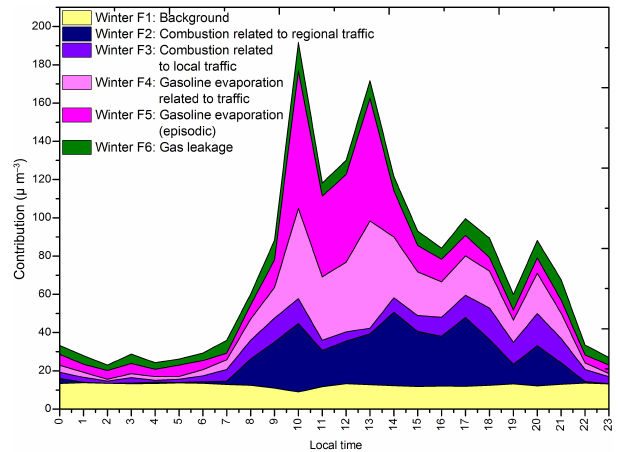
Figure 3. Diurnal variation of source contribution (µgm − 3 ) to NMHC concentrations in winter 2012.